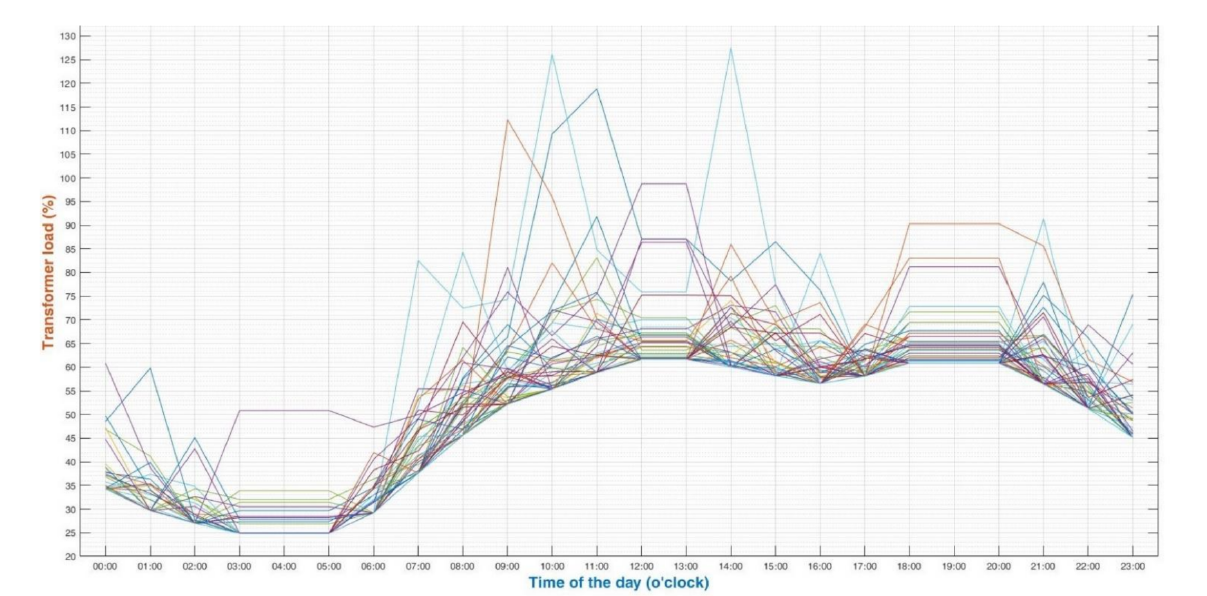
Figure 14. Capacity congestion of the transformers when CS1 is